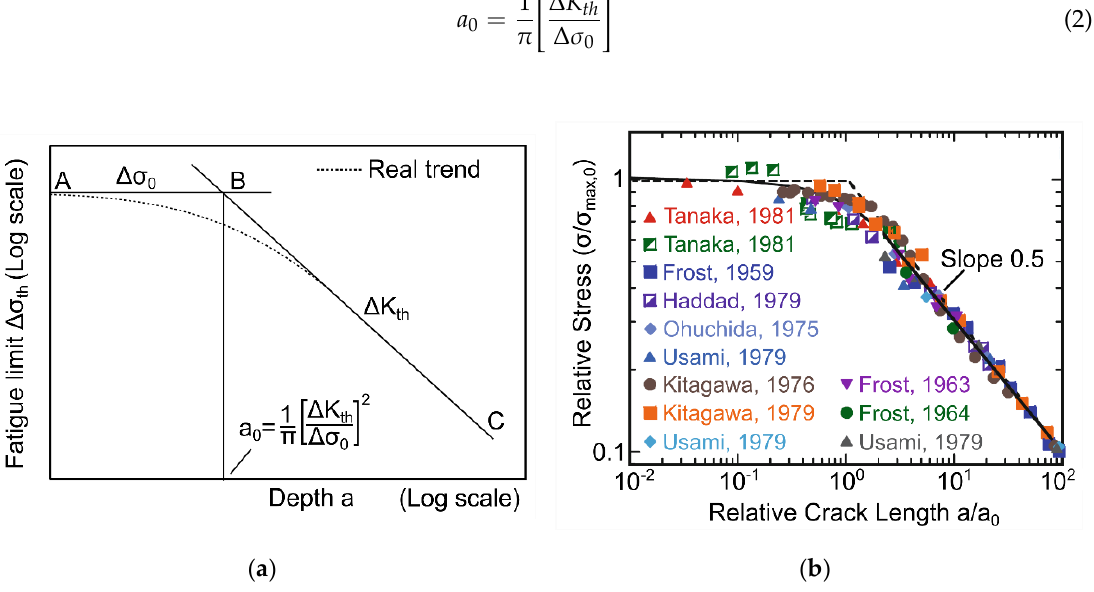
Figure 2. Fatigue strength σ th dependent on defect size a , the intrinsic defect size a 0 , and threshold of stress intensity factor range for long-crack propagation ∆ K th : ( a ) Schematic illustration [22] and ( b ) experimental validation [23].